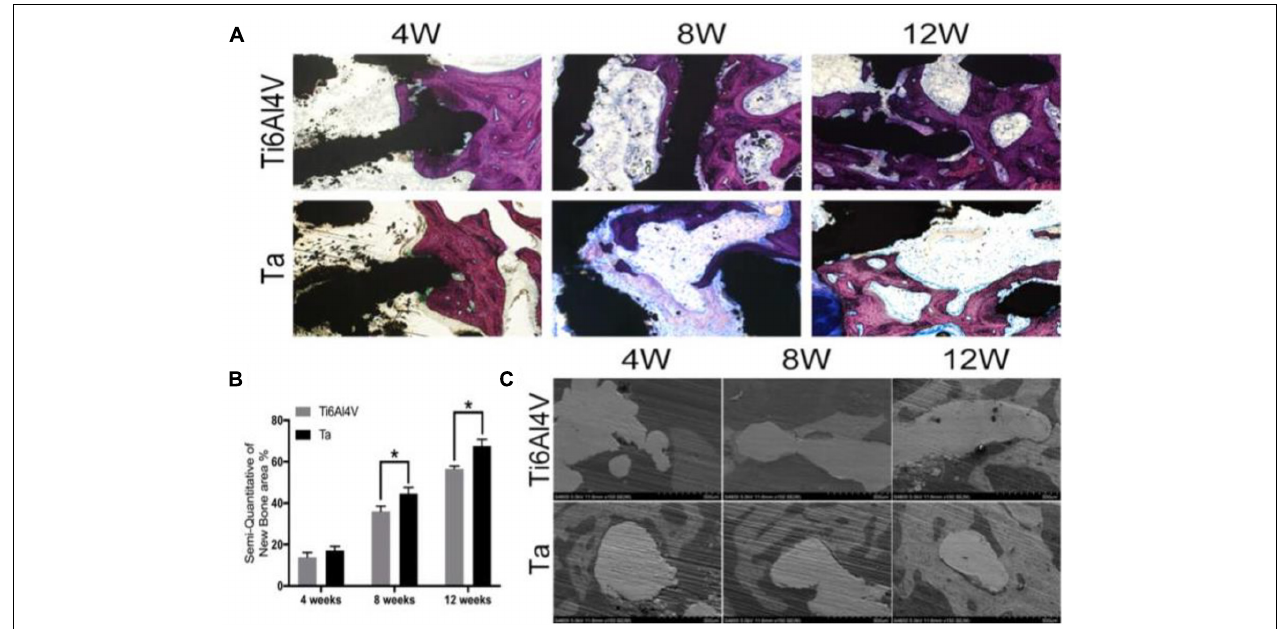
FIGURE 5 | Hard tissue section stained by van Gieson staining (A) and histomorphometric analysis (B) of Ti6Al4V and Ta scaffolds at 4, 8, and 12 weeks after surgery. The red-stained tissue represents bone tissue; at 4 weeks, the amount of new bone tissue in the scaffolds is thin and irregular. Osteoblasts seam with bone-lining cells, indicating active bone formation. * P < 0.05, vs. Ti6Al4V group. (C) SEM images of bone apposition and bone microstructure on porous scaffolds at different positions at 4, 6, and 12 weeks. White: implant; gray: new bone. Reproduced from Guo et al. (2019) with permission from the American Chemical Society (Copyright